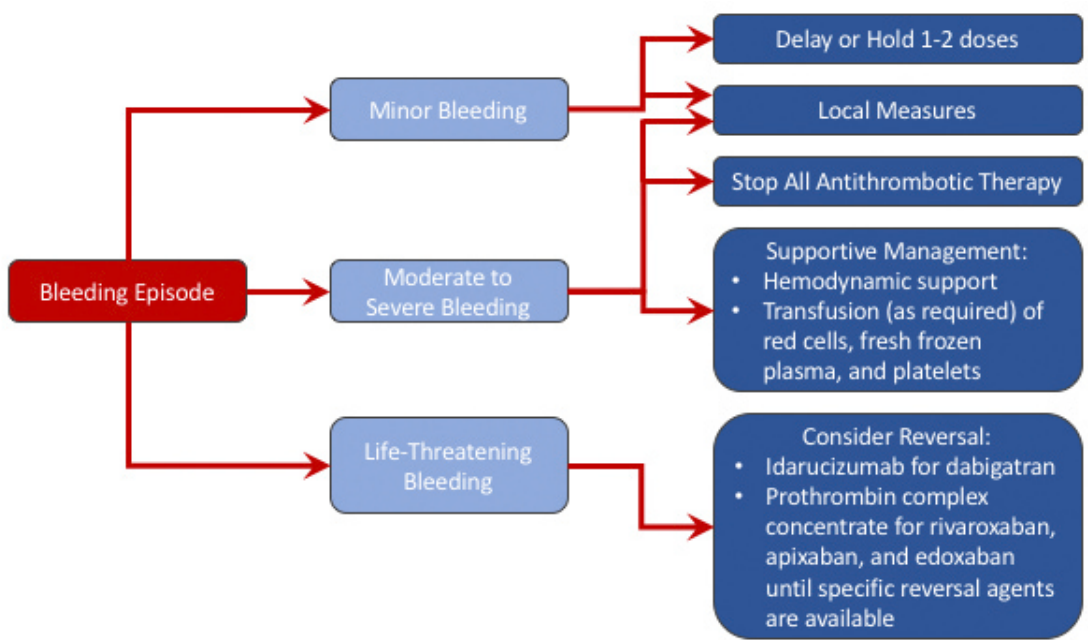
Figure 1. Management of direct oral anticoagulant-associated bleeding. With minor bleeding, local measures and delaying or holding 1–2 doses is sufficient. With moderate to severe bleeding, the direct oral anticoagulant should be held, and supportive therapy should be administered. For life-threatening bleeding, reversal should be